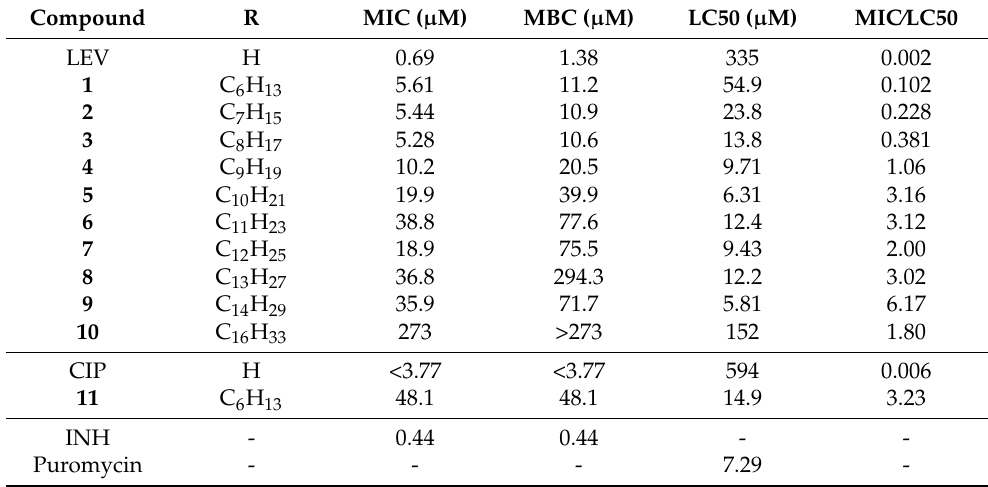
Table 2. Results obtained for the lethal concentration 50 (LC50), in µ M, the MIC in µ M and the ratio of the LC50 and MIC values for the various esters